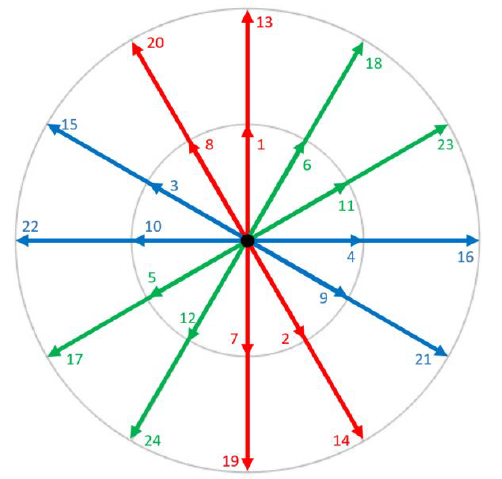
Figure 6. Star of slot 10th magneto-motive force (MMF) harmonic.